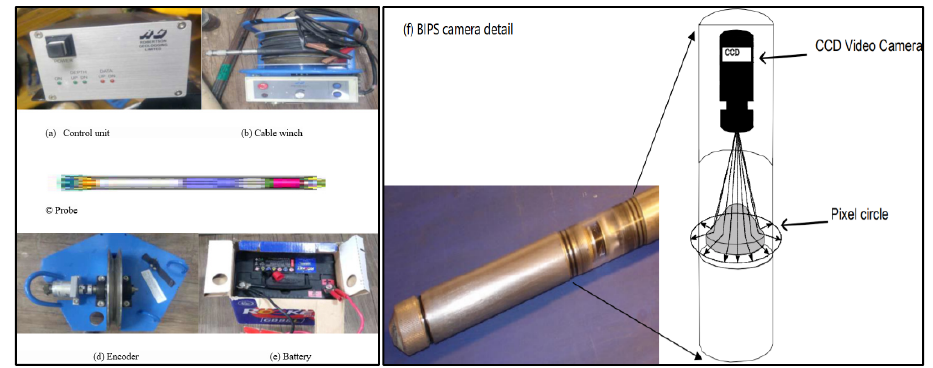
Figure 22. Main equipment accessories of BIPS system, ( a ) control unit, ( b ) cable winch, ( c ) probe, ( d ) depth encoder, ( e ) battery, ( f ) BIPS camera detail.